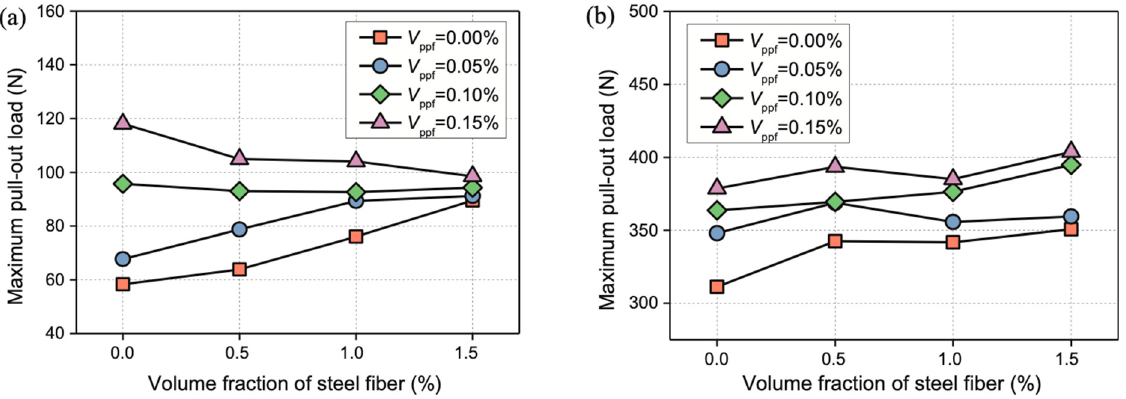
Figure 13. Effect of steel fibre dosage on maximum pull-out load (P max ) for specimens including ( a ) straight fibres and ( b ) hooked-end fibres [11].